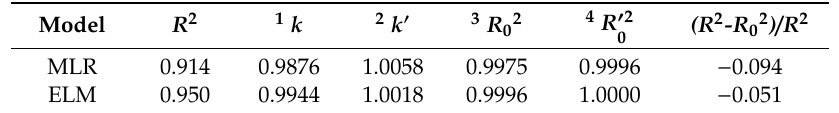
Table 3. The results of external validation of the test set in the multiple linear regression (MLR) and extreme learning machine (ELM) models.